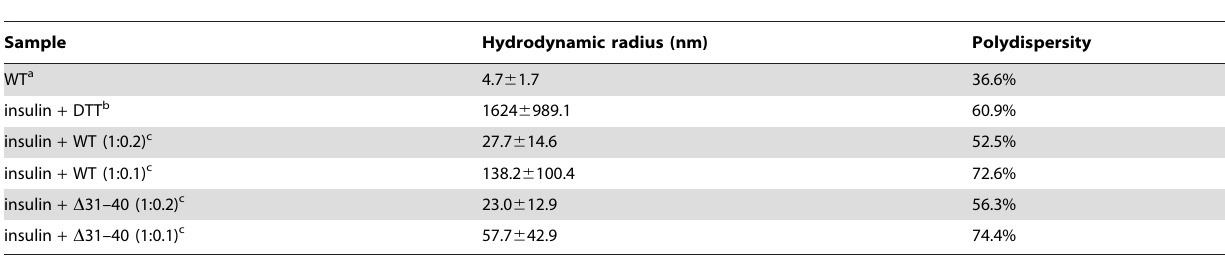
Table 3. Size analysis by DLS of aggregated